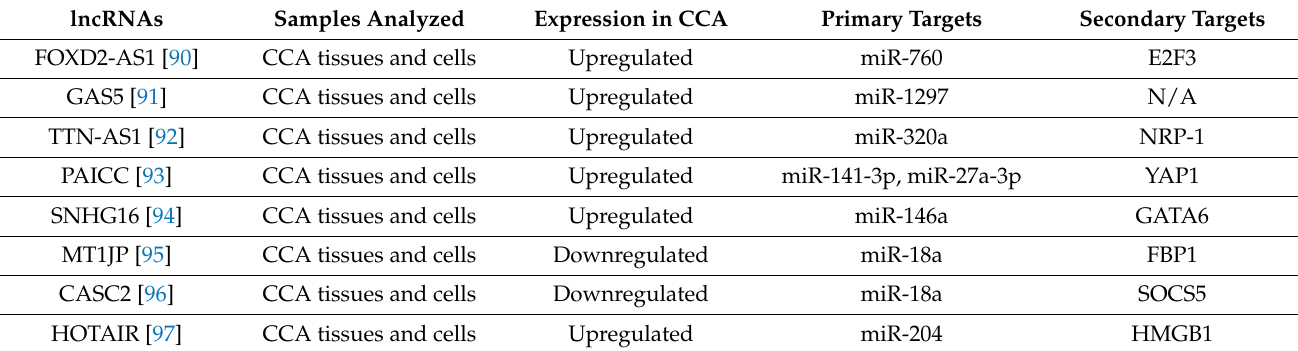
Table 4. Selected lncRNAs identified in recent CCA